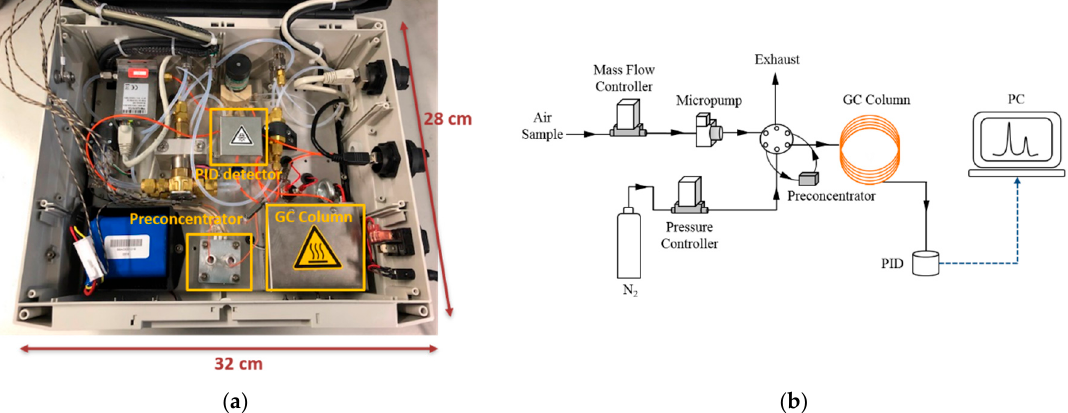
Figure 1. ( a ) Photograph of the compact gas chromatographs (GC) prototype and ( b ) schematic view of the device updated with a preconcentration unit.